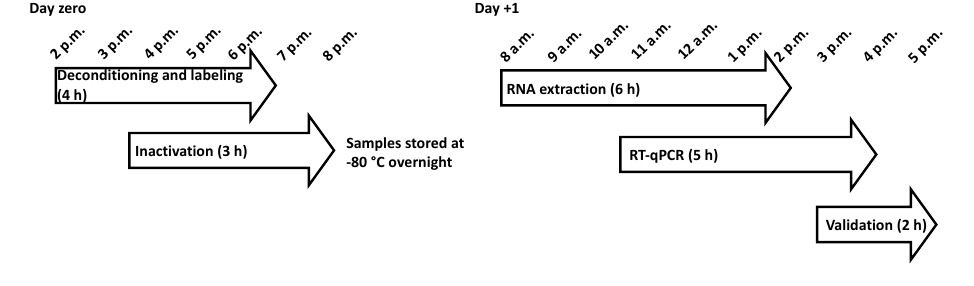
Figure 6. Timeline of the process.